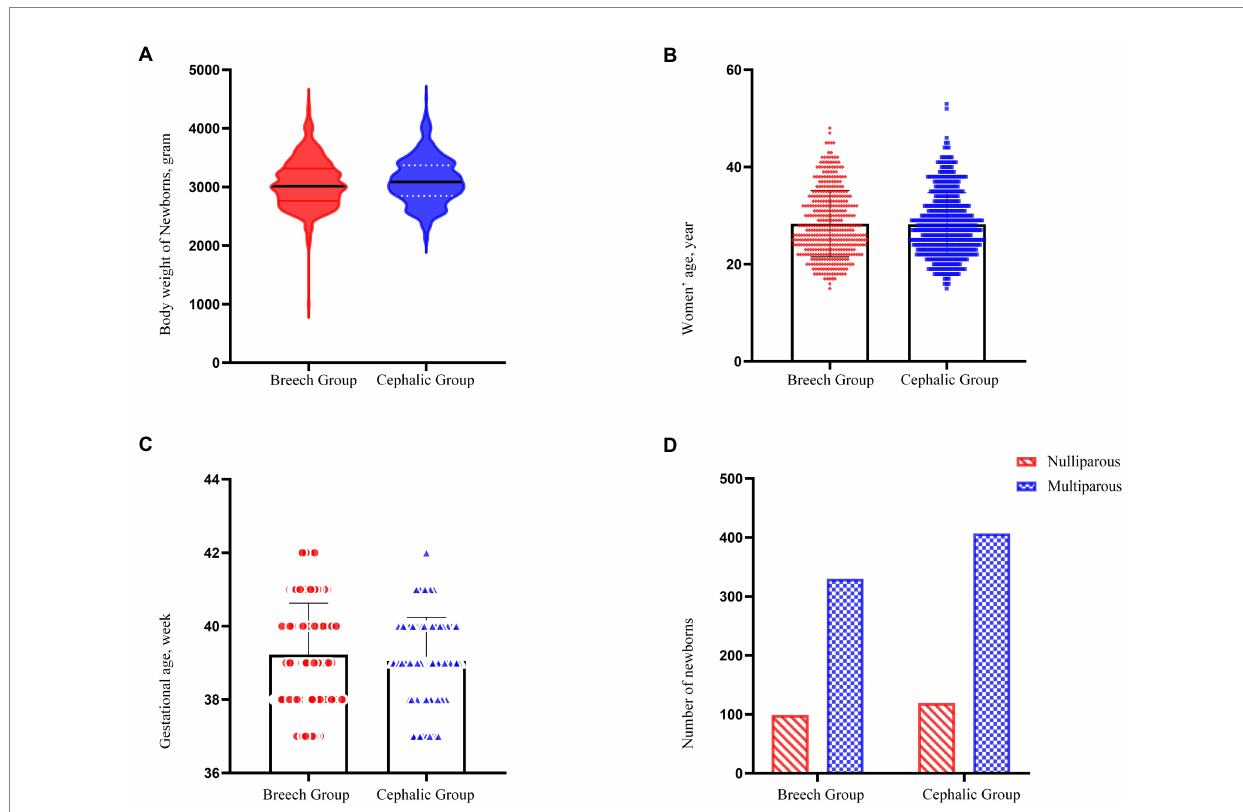
FIGURE 3 Comparison between breech and cephalic presentation. (A–C) Shows a comparison of body weight of newborns, maternal age and gestational age between the breech group and cephalic group ( p = 0.115, 0.761, 0.052, respectively). (D) Shows the number of multiparous and nulliparous between two groups ( p =